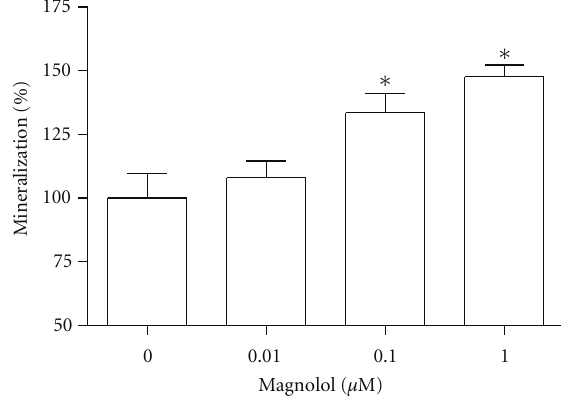
Figure 4: E ff ect of magnolol on the mineralization of osteoblastic MC3T3-E1 cells. Data were expressed as a percentage of control. The control value for mineralization was 0.504 ± 0.006 OD/10 6 cells. ∗ P < 0 . 05 compared with